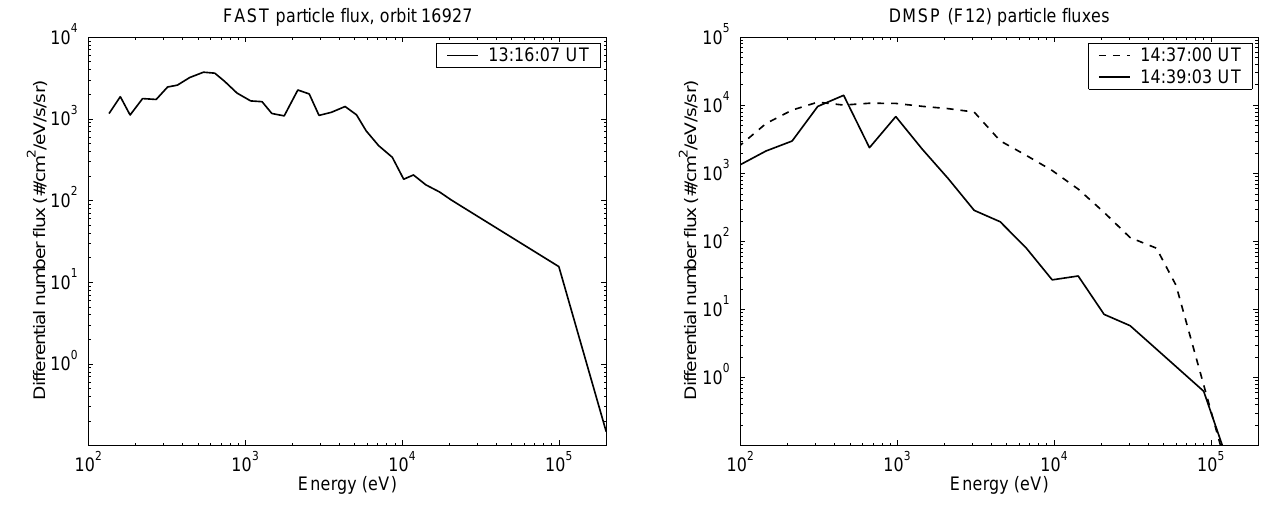
Fig. 8. FAST input particle flux at 13:16 UT with high energy ex- trapolation.